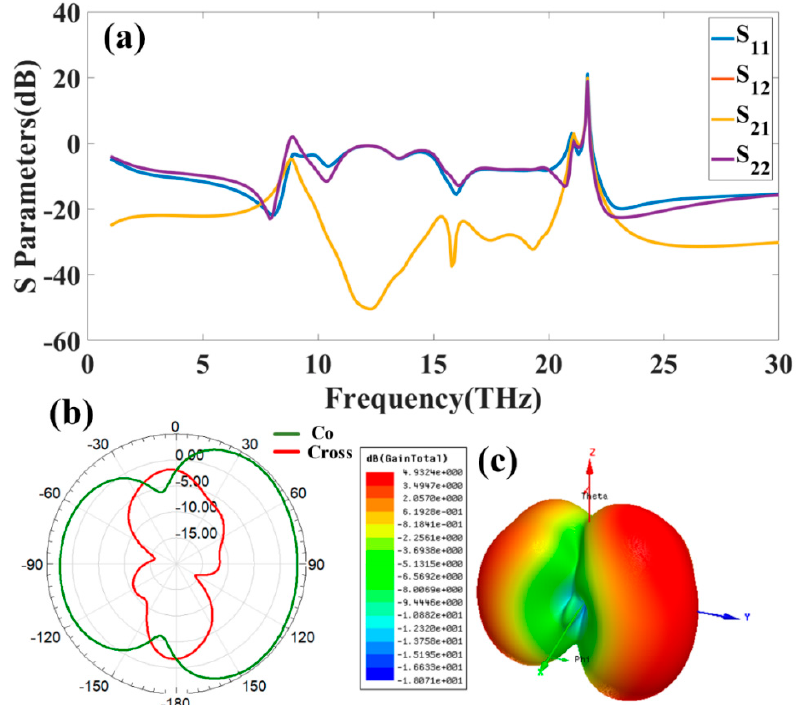
Figure A1. ( a ) Calculated S parameters for the type-2 antenna. Calculated directivity in ( b ) 2D (with co- and cross-polarization) and ( c ) 3D, by considering single-port (Port 1) excitation.